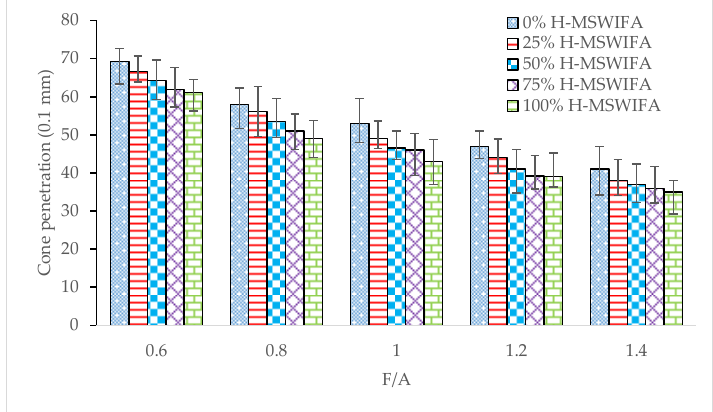
Figure 2. CPT results.